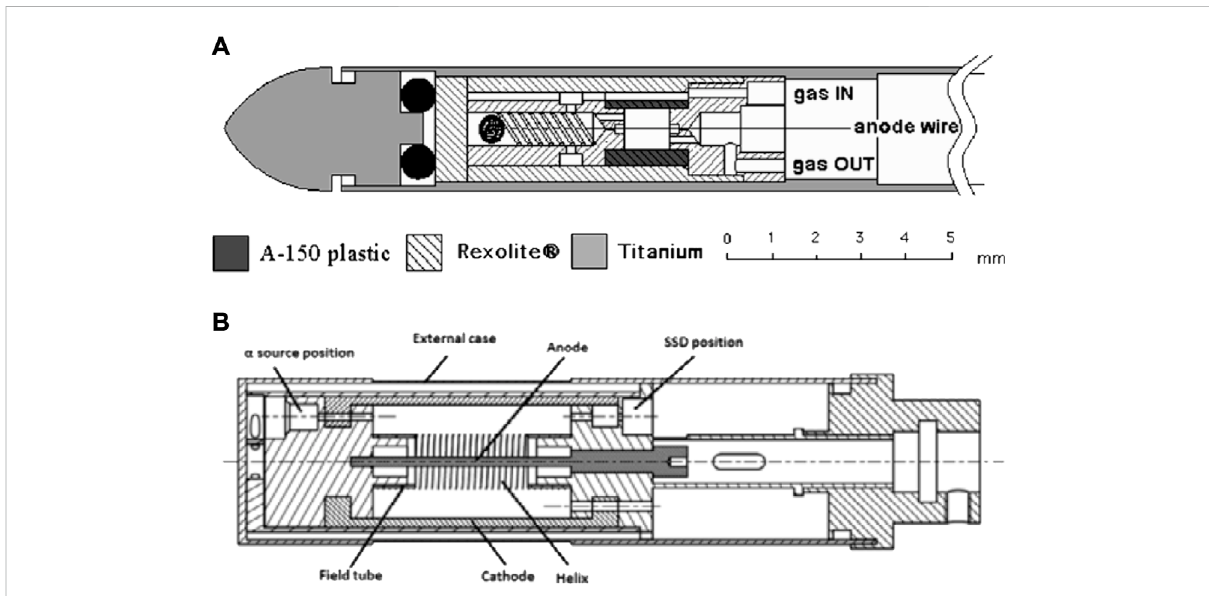
FIGURE 2 Schematic cross-section of a mini-TEPC and of the avalanche con fi nement TEPC. (A) Cut view of the mini-TEPC. Source: [28]. (B) Cross- sectional view of the avalanche-con fi nement TEPC. Source: